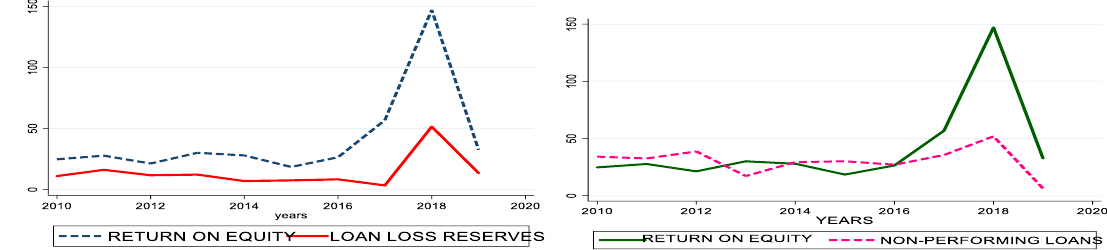
Figure 9: Cointegration between LLRs and ROE Figure10: Inverse moves between NPLs &